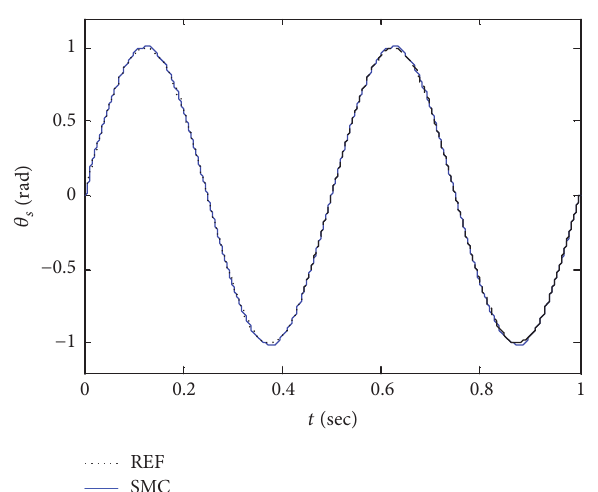
Figure 10: The tracking trajectory under SMC-controller.